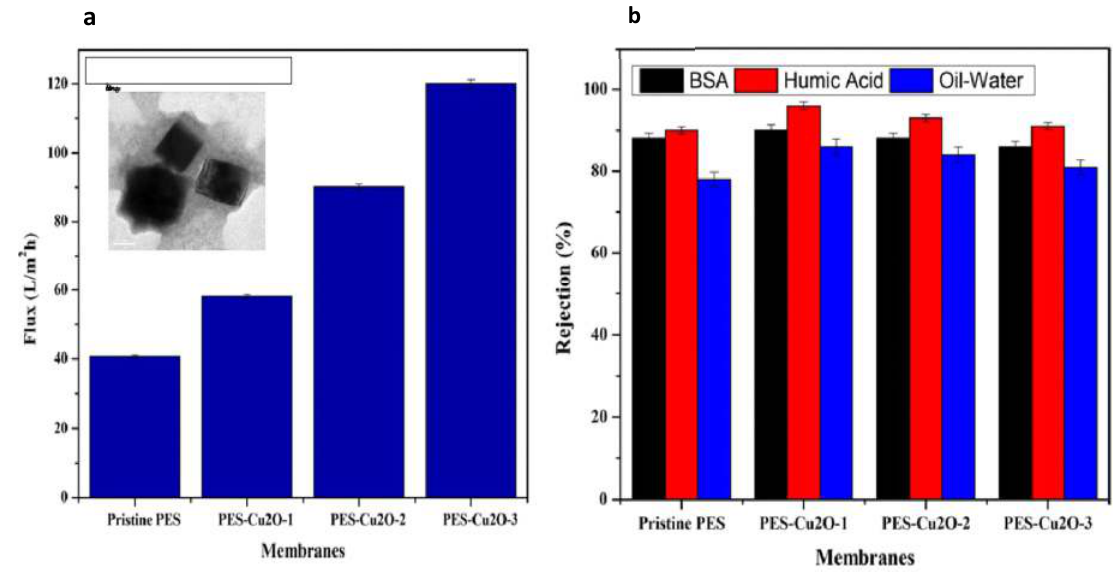
Figure 12. PES UF Membranes performance. PWF of neat membrane with respect to modified membranes given their incorporation into Cu 2 O-NPs, the inset figure exhibits a TEM image of Cu 2 O-NPs ( a ) and rejection of BSA, HA and Oil-Water ( b ). Modified from Pravallika et al. (2016) [50].